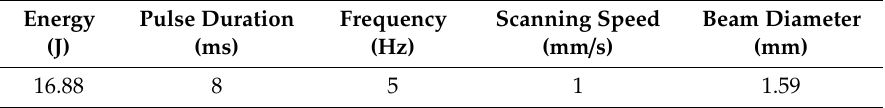
Figure 1. The schematic diagram of laser bionic processing. Table 2. Laser processing parameters.